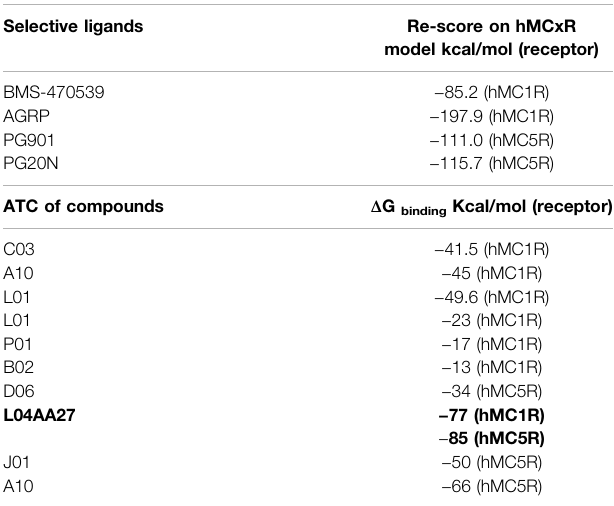
TABLE 1 | Virtual screening of FDA approved compounds to be repurposed as melanocortin ligands. Bold text within the table is referred to the predicted binding free energy of fi ngolimod, respectively to hMC1R and to hMC5R, as reported in round